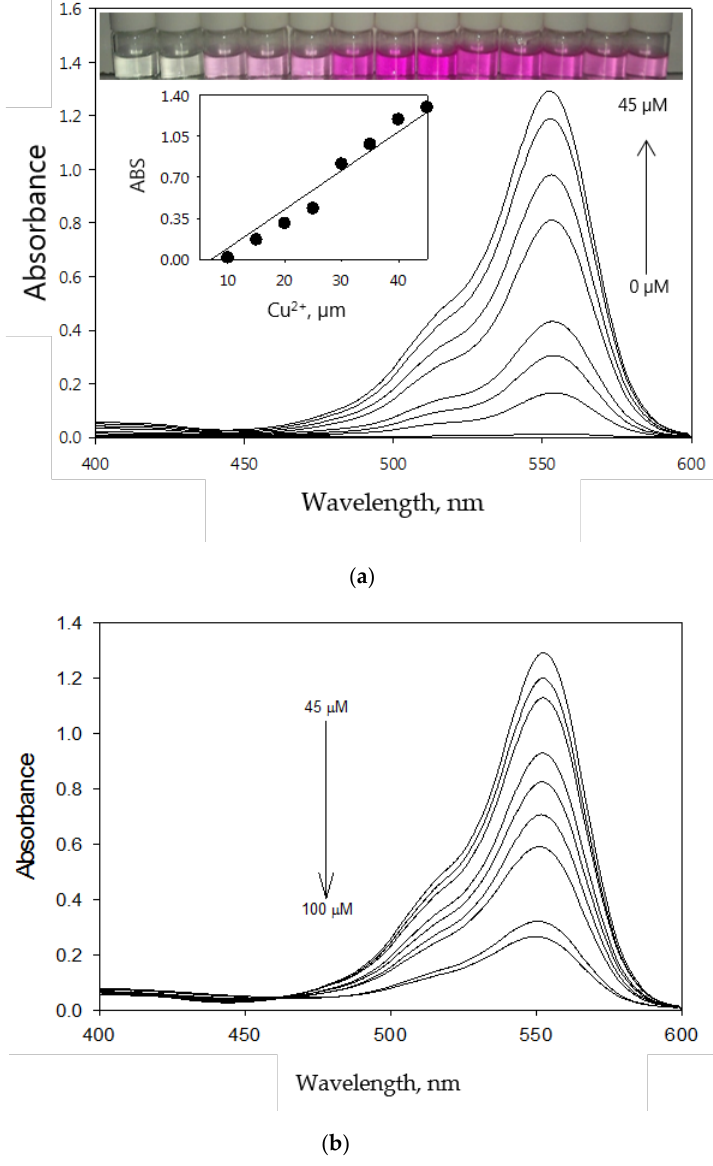
Figure 5. Absorbance spectra of RECM (50 µM) in CH 3 CN in the presence of ( a ) 0–45 µM and ( b ) 45–100 µM of Cu 2+ , respectively, Inset: Linear absorbance response of RECM (50 µM) in CH 3 CN within the Cu 2+ concentration range of 1–45 µM.